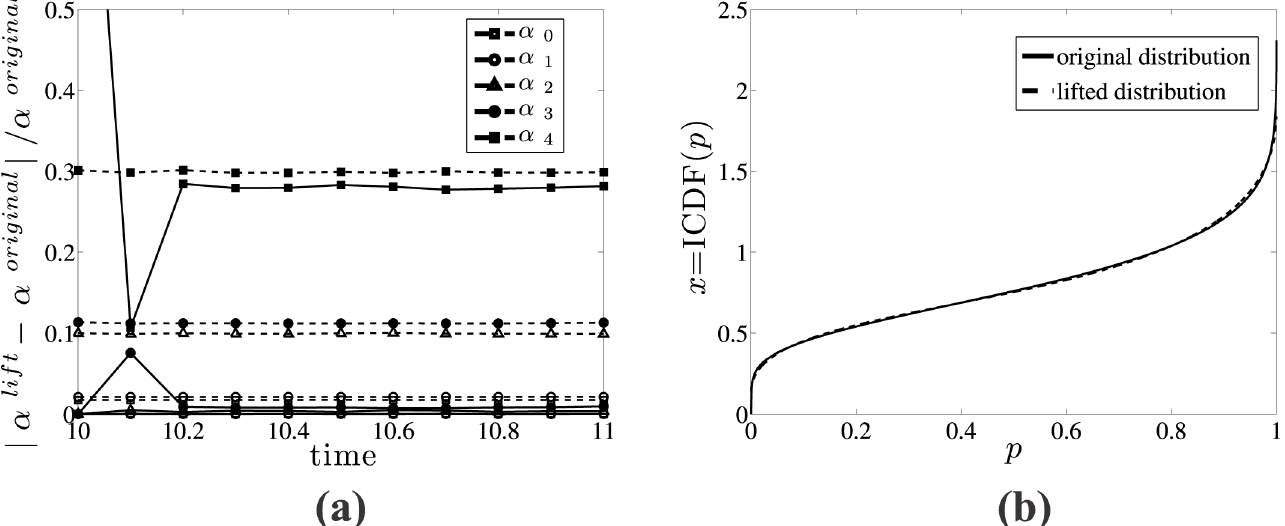
Fig 4. Computation of healing time. (a) Relative error between five “ original ” coefficients and coefficients computed after lifting. The solid lines correspond to relative errors, while dashed lines correspond to stochastic noise quantified by 2 s a computed using 50 direct CNMC copies. (b) The original ( solid line ) and the lifted ( dashed line ) ICDF distributions using 4 orthogonal basis functions at dimensionless time τ = 10.5.